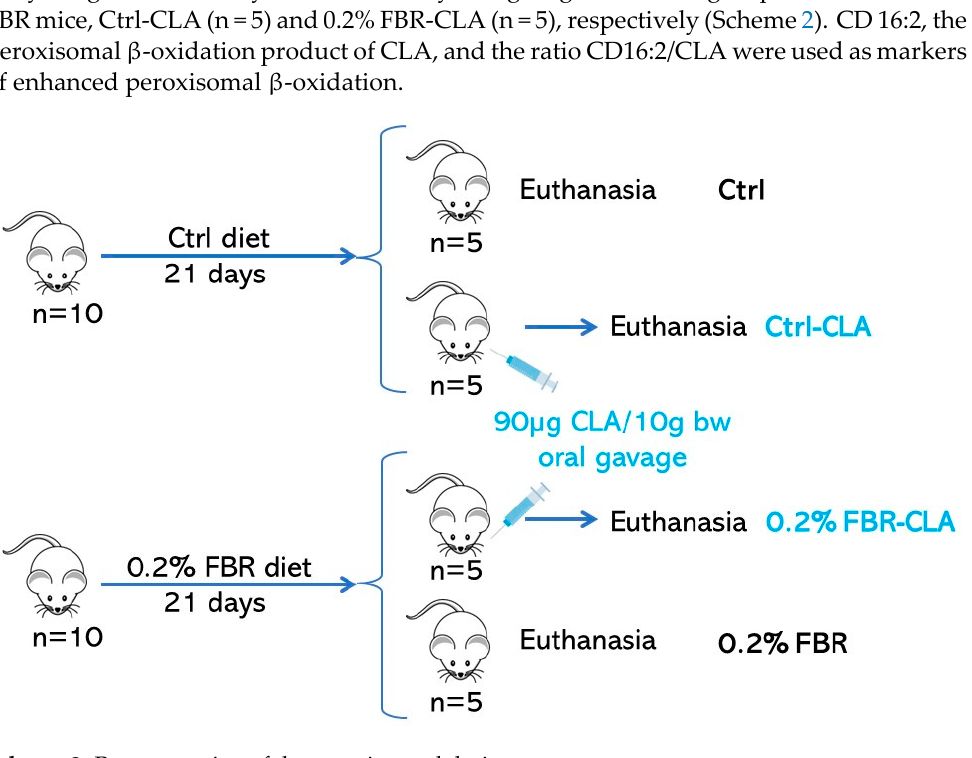
Scheme 2. Representation of the experimental design. Table 3. Main dietary fatty acid (FA) composition (g/100 g diet) of 2016 Teklad Global control diet as reported by the manufacturer Envigo. Dietary experimental treatments: control diet (Ctrl), con-